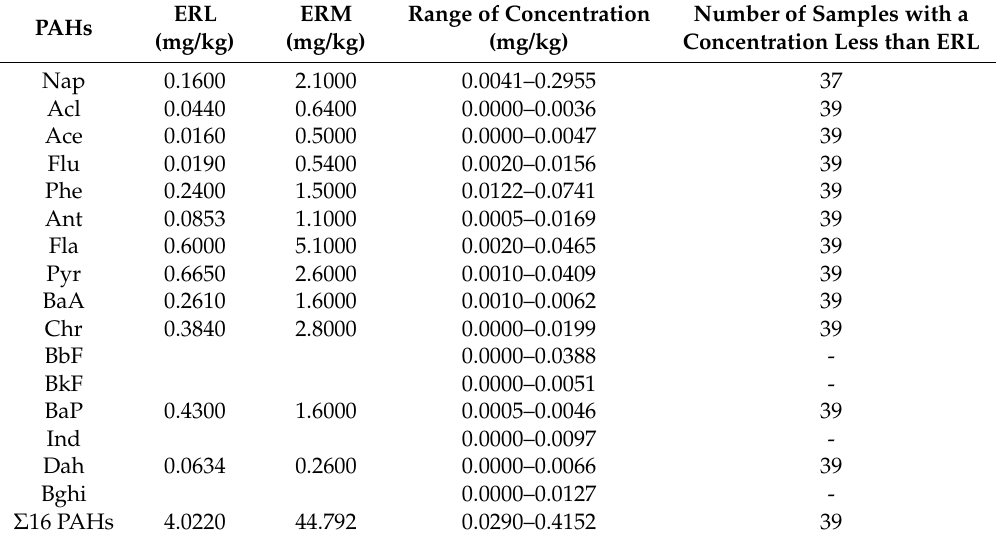
Table 5. Biological toxicity assessment form of PAHs in soils of the Momoge Wetland.